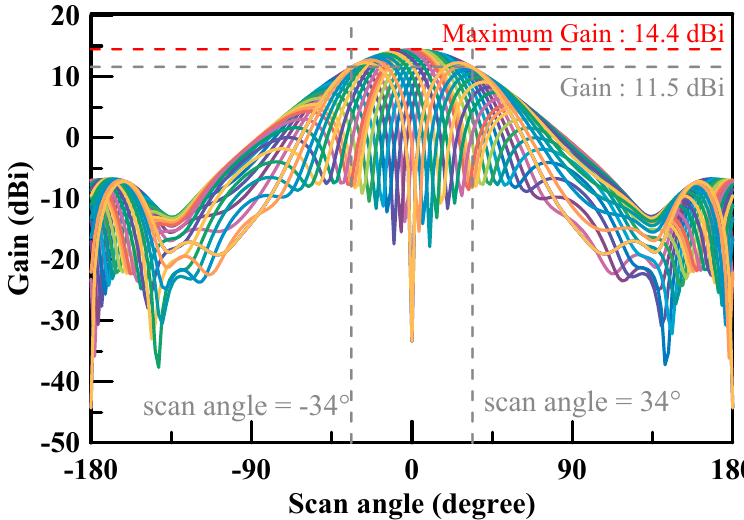
Figure 11. Simulation results of the beam steering pattern at 28 GHz (X-cut).